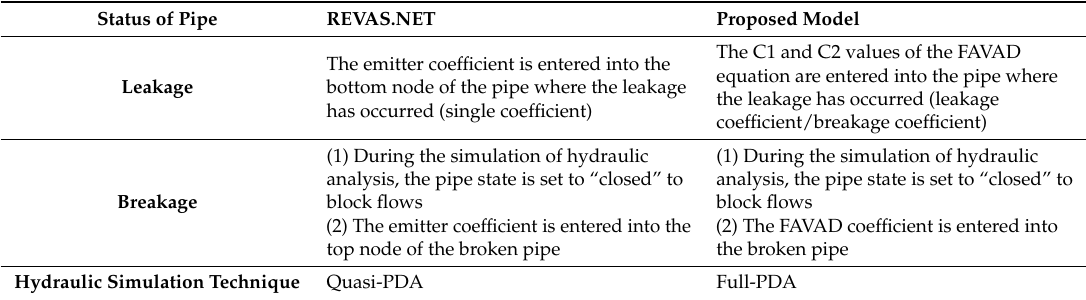
Table 3. Comparison between the proposed model and